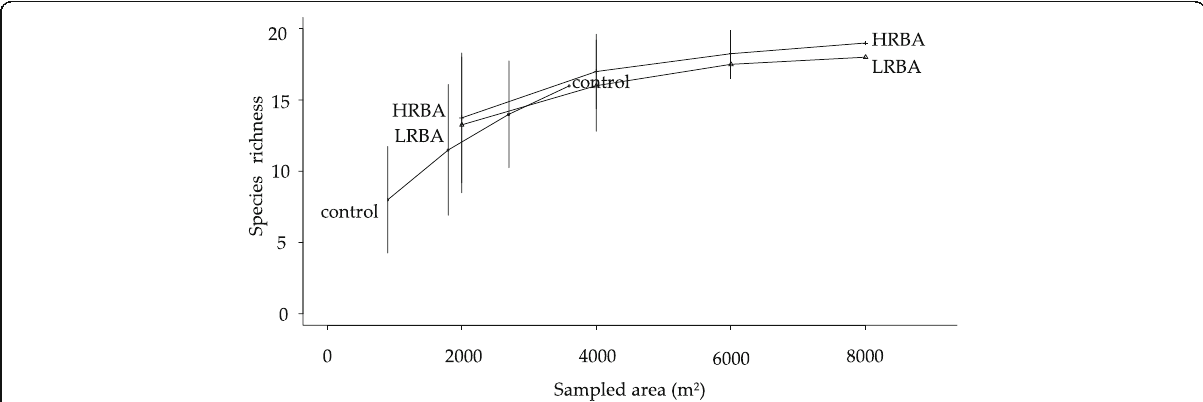
Fig. 3 Species rarefaction curves showing the mean tree species richness per sampled area for the control, high and low residual basal area (HRBA and LRBA) plots after harvesting. The rarefaction curves were calculated through repeatedly re-sampling richness out of a random pool of samples constructed out of the four sampled plots